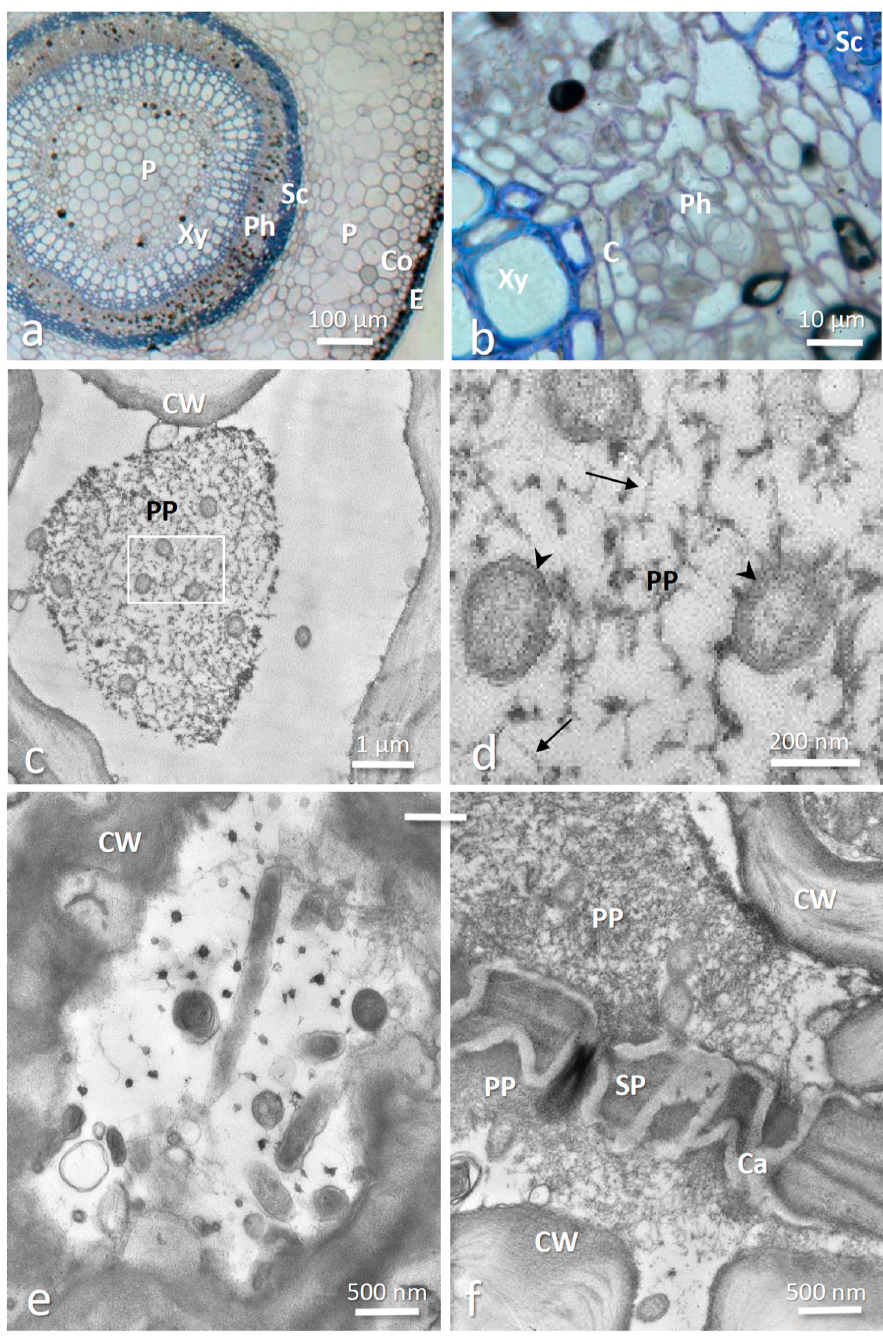
Figure 2. TEM observation of Phlomobacter in phloem sieve elements of stolons. ( a , b ) Cross-sections of an infected stolon stained with toluidine blue, showing the tissular organization and particularly the location of the phloem layer between the cambium and the sclerenchyma ( b ). ( c – f ) TEM micrographs of phloem sieve elements revealed the presence of numerous bacteria, which were frequently surrounded by P-protein filaments. ( d ) Enlarged view of the framed area in ( c ). The inner and outer membranes of the typical cell wall of Gram-negative bacteria are clearly visible (arrowheads), as well as the bead-string structure of P-protein filaments (arrows). ( e ) When cut longitudinally, the bacteria appeared as long rods, the typical shape of Phlomobacter and other bacteria of the genus Arsenophonus. ( f ) Bacteria and P-protein aggregates on both sides of a sieve plate lined by callose deposition between two sieve elements. C = Cambium; Ca = Callose; Co = Collenchyma; CW = Plant cell wall; E = Epidermis; P = Parenchyma; Ph = Phloem; PP = P-proteins; Sc = Sclerenchyma; SP = sieve plate; Xy = Xylem.